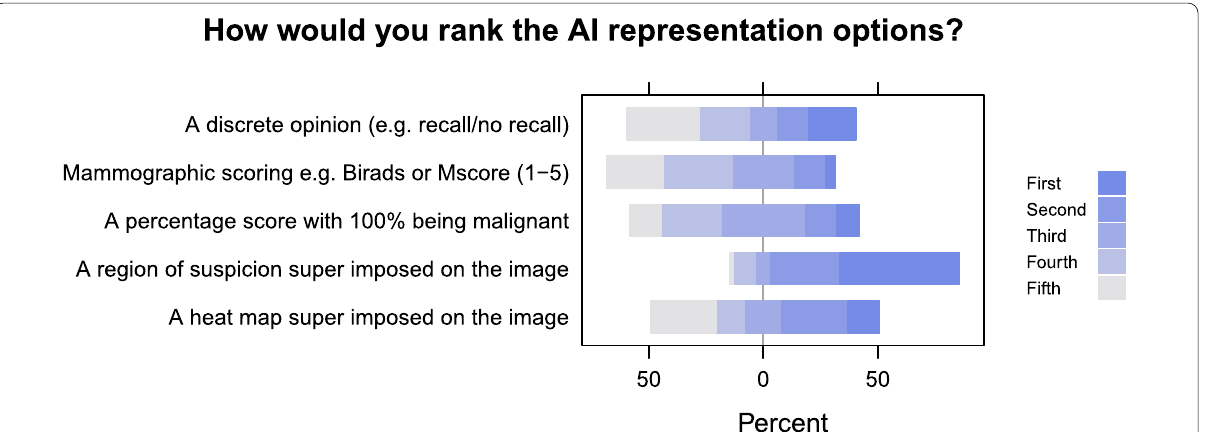
Fig. 3 How should the AI opinion be represented? Participants were asked: “If you were able to see the AI opinion as in the companion scenario, how best do you think this should be represented?” Participants were shown five options and were asked to rank them from most to least